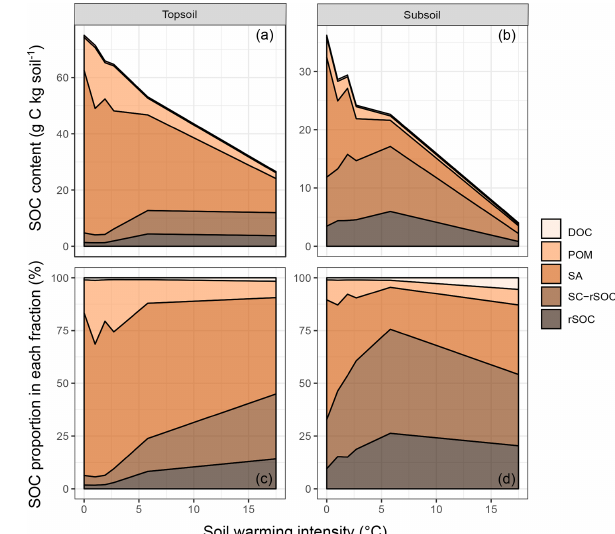
Figure 1. Areal plots of (a) the soil organic carbon (SOC) content in the topsoil and (b) the SOC content in the subsoil as well as (c) the SOC proportion in each fraction of the topsoil and (d) the SOC proportion in each fraction of the subsoil as a function of warm- ing intensity. Fractions were dissolved organic carbon (DOC), par- ticulate organic matter (POM), SOC in sand and aggregates (SA), non-oxidation-resistant silt- and clay-sized SOC (SC-rSOC), and oxidation-resistant silt- and clay-sized SOC (rSOC).